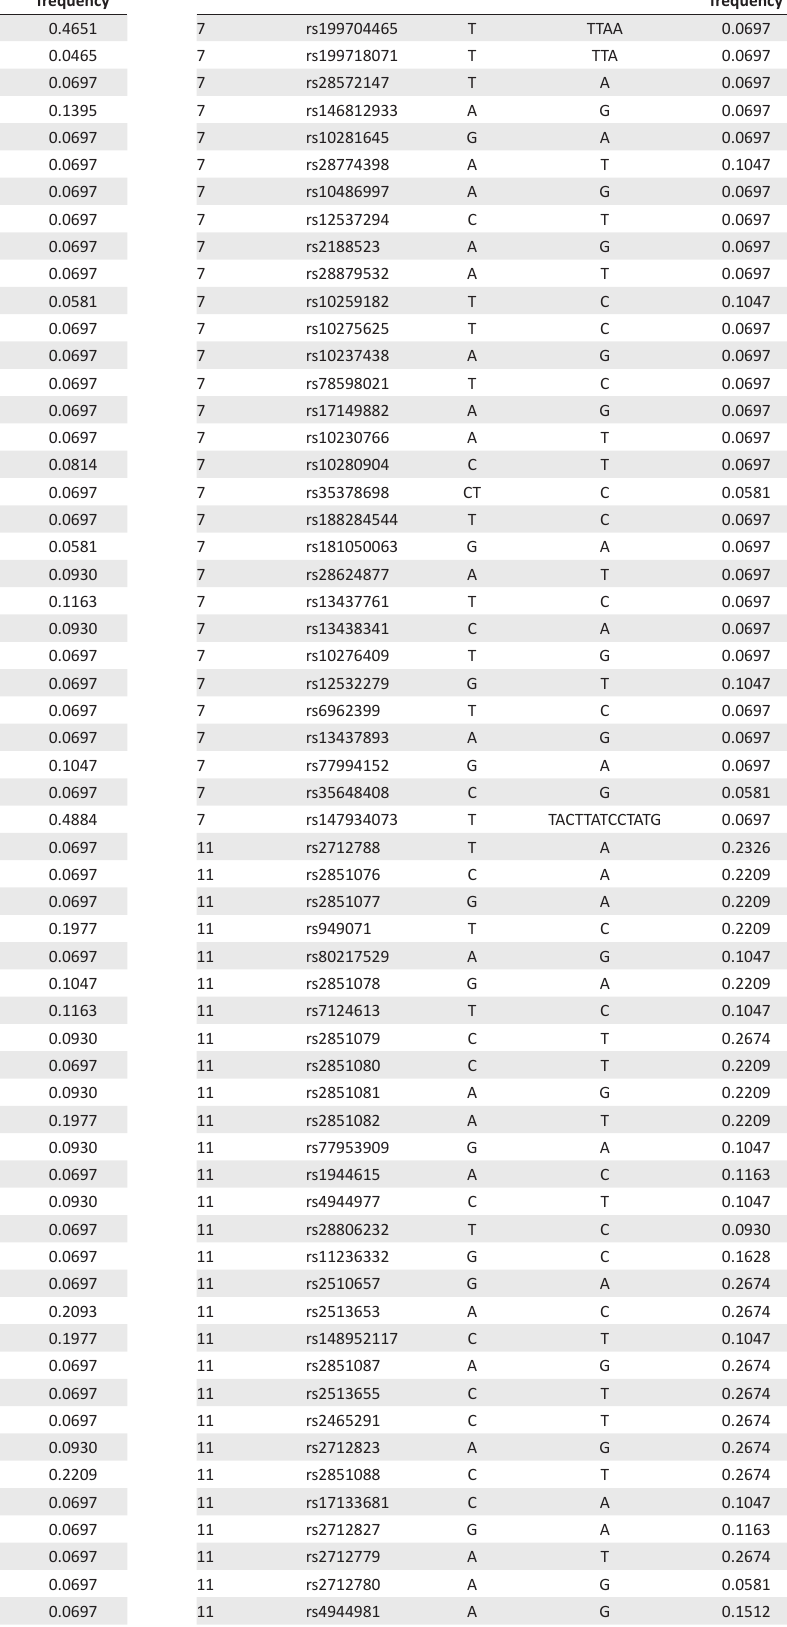
Table 1-A1 (Continues...): Minor allele frequencies for 1846 polymorphisms in 43 black South Africans. Chromosome Polymorphism Minor allele